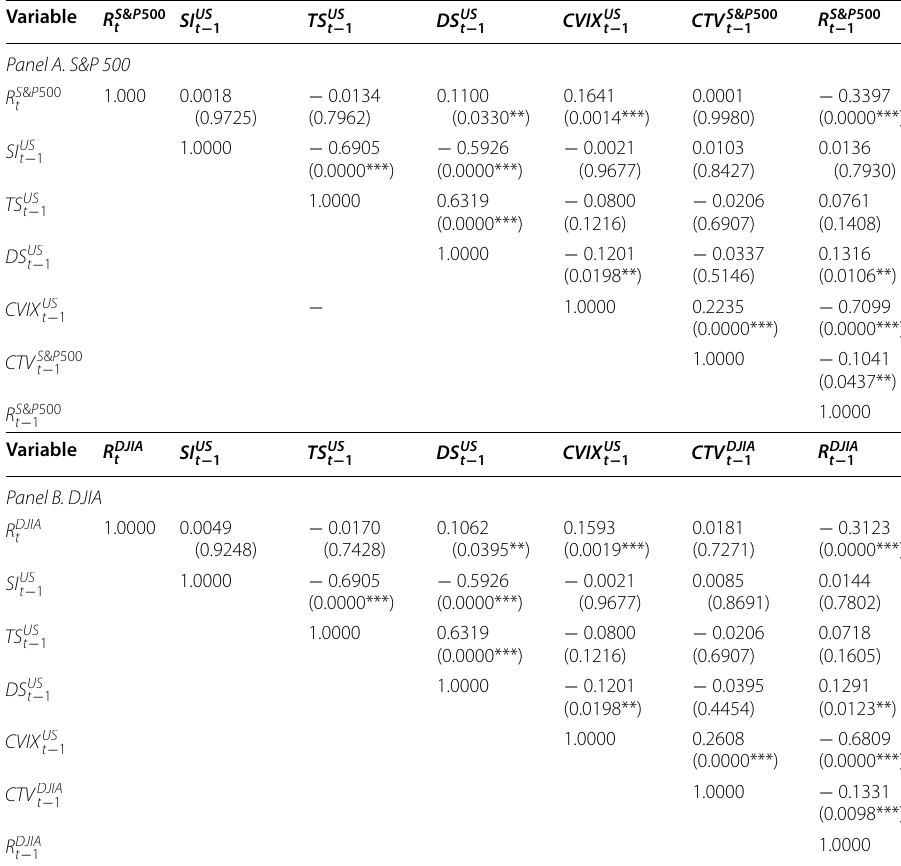
Table 3 Correlation Matrix: